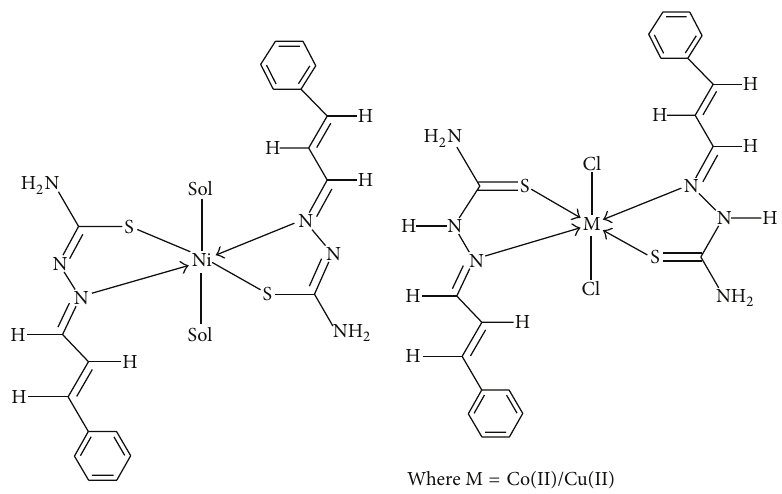
Figure 2: Tentative structures of copper(II), Ni(II), and Co(II)